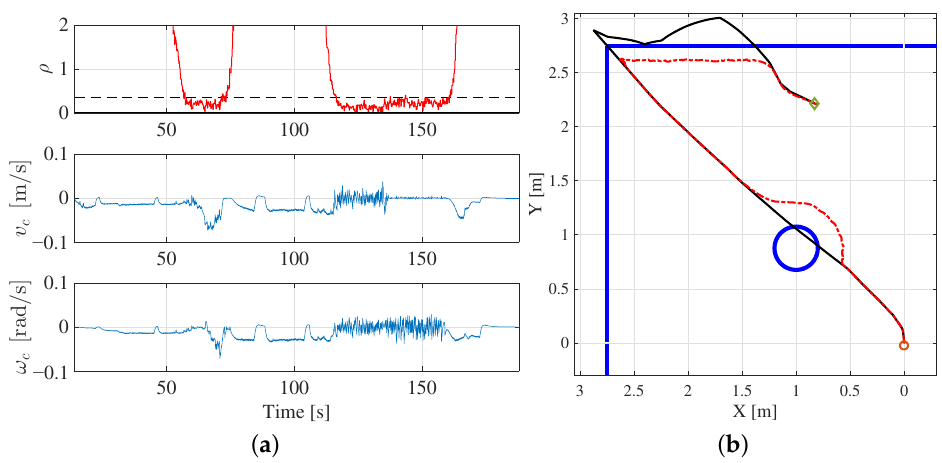
Figure 5. Case study 1: robot control performance. ( a ) Top graph: normalized distance ρ between the detected obstacles and the mobile robot boundary (the dashed line represents the distance threshold ρ 0 for the activation of the repulsive force). Middle and bottom graphs: linear and angular velocity commands for the mobile robot. ( b ) 2D robot trajectory: starting robot position (small orange circle); ending robot position (small green diamond); robot trajectory (red dashed line); user reference trajectory (solid black line); and obstacles (solid-thick blue